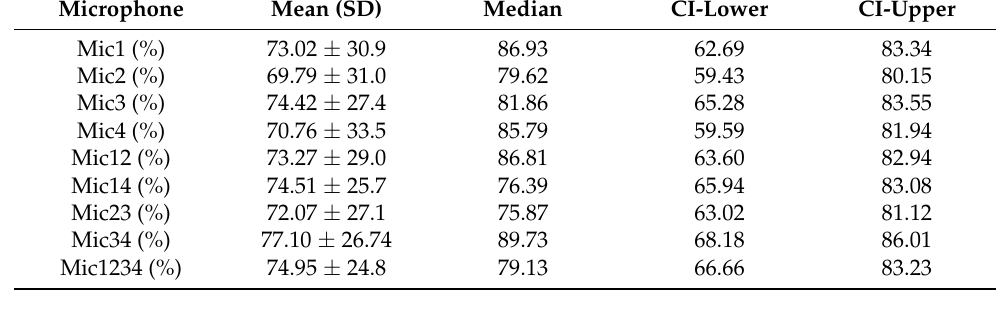
Table 1. Descriptive statistics from the accuracy in predicting running style using vertical ground reaction forces generated from sound data (% of total predictions). SD = standard deviation; CI ‐ lower = lower bound of the 95% confidence interval; CI ‐ upper = upper bound of the 95% confidence interval.